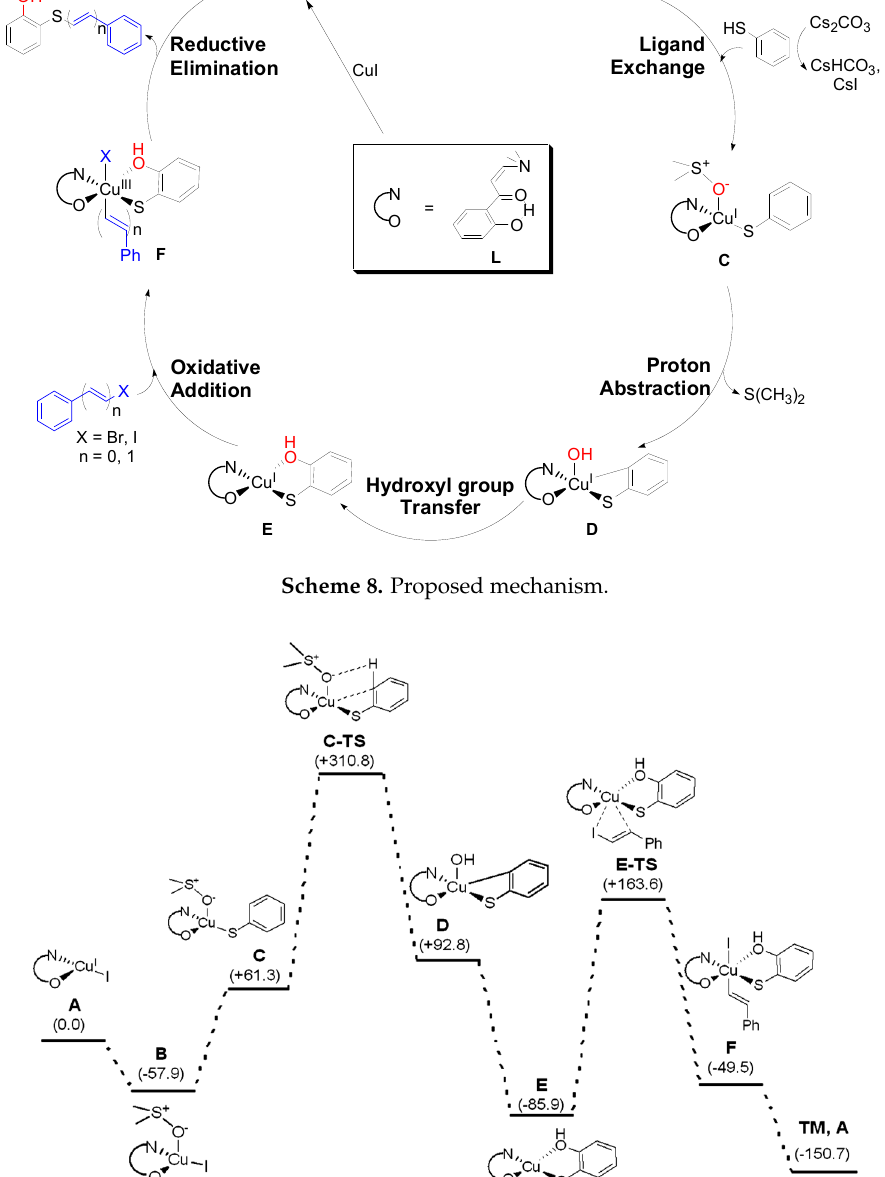
Figure 5. Energy profile of Cu-catalyzed direct C-H hydroxylation/C-S coupling.